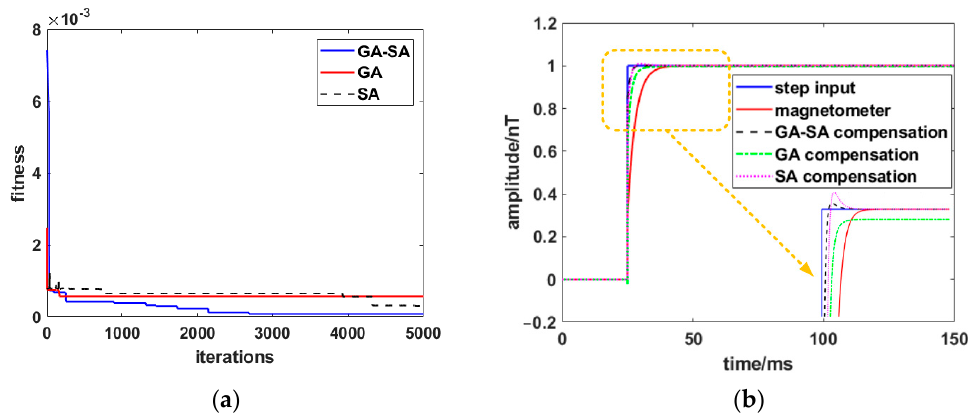
Figure 12. GA, SA, and GA-SA algorithm simulation comparison: ( a ) fitness convergence curve; ( b ) compensated response curve. Table 3. GA, SA, and GA-SA algorithm performance comparison.